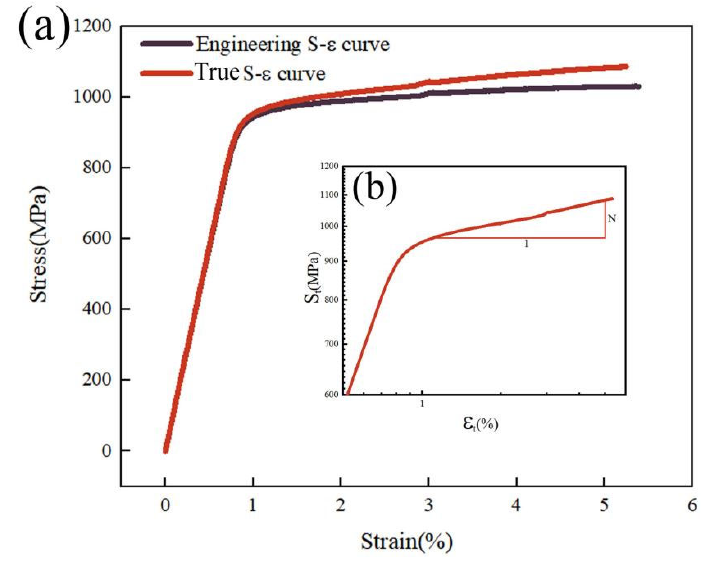
Figure 5. ( a ) True stress–strain curve of IFW joint; ( b ) lgS t -lg ε t curve.